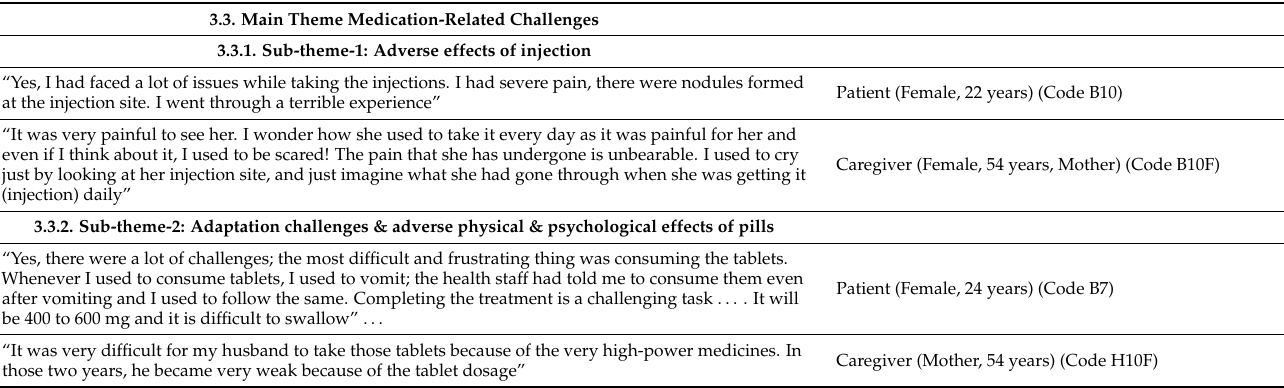
Table 3. Quotes reflective of the theme “Medication related challenges” and its